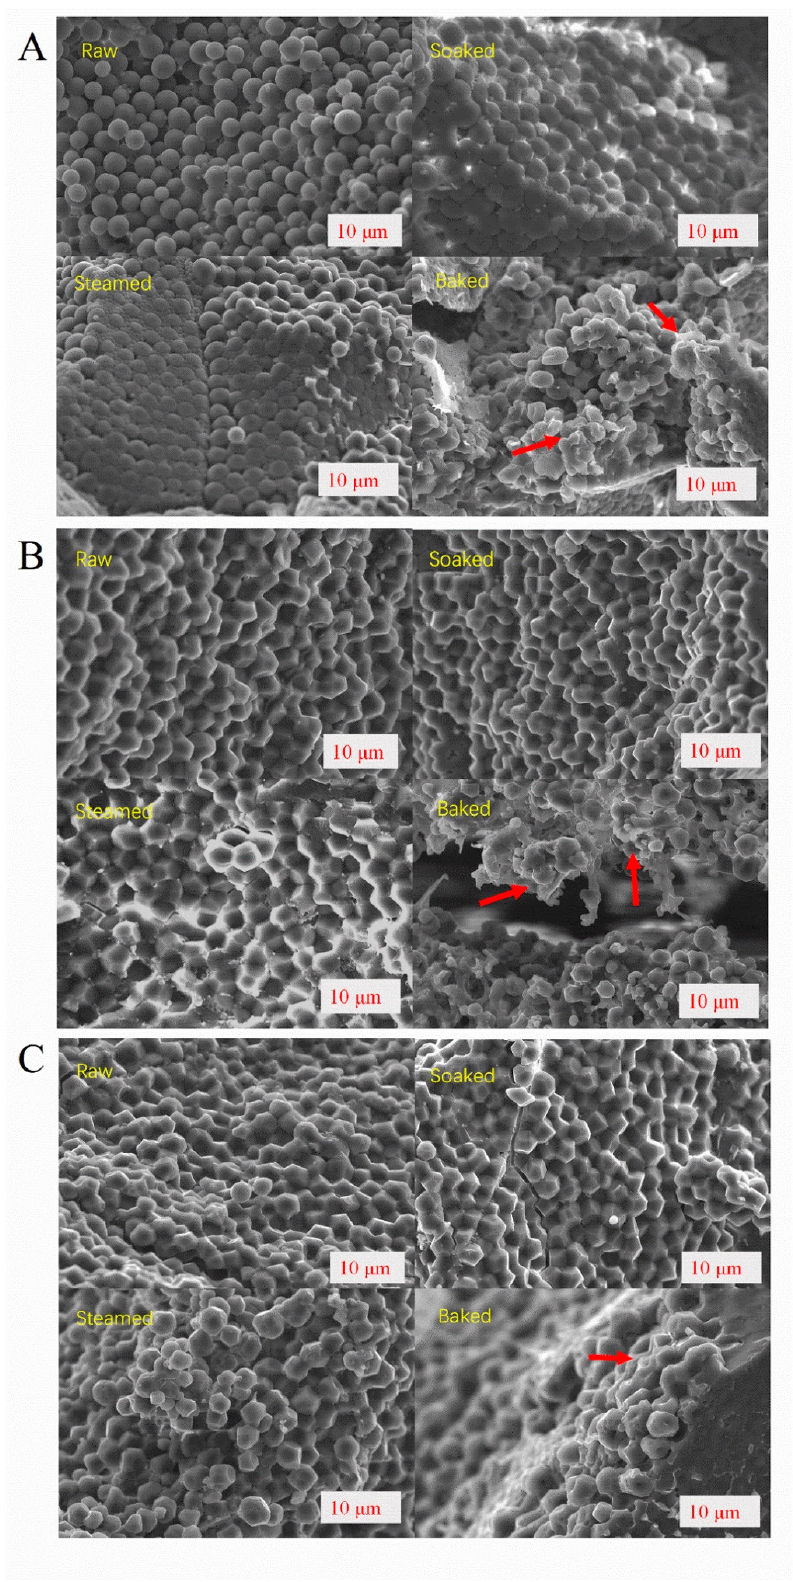
Figure 4. Scanning electron micrographs of raw and different processed millets at 1000× magnification with 10 μ m scale bars. ( A – C ) represents M1, M2, M3, respectively.